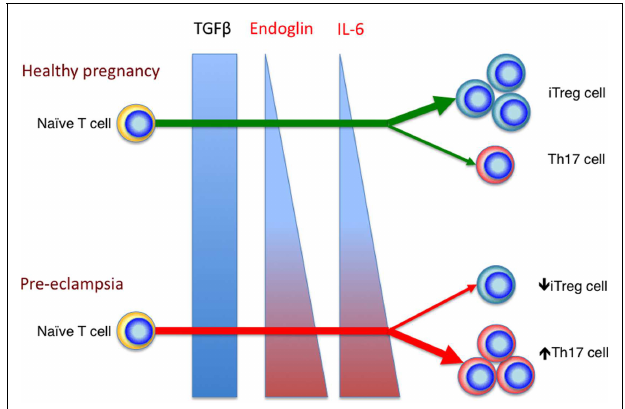
FIGURE 2 | Reciprocal development of iTreg andTh17 cells in healthy pregnancy and pre-eclampsia . In the relative absence of IL-6 and endoglin,TGF β signaling enhances iTreg, but notTh17 cell differentiation in healthy pregnancy. In pre-eclampsia, the elevated level of endoglin could reduceTGF β signaling, which in combination with the increased IL-6 level, would deter iTreg cell induction, but driveTh17